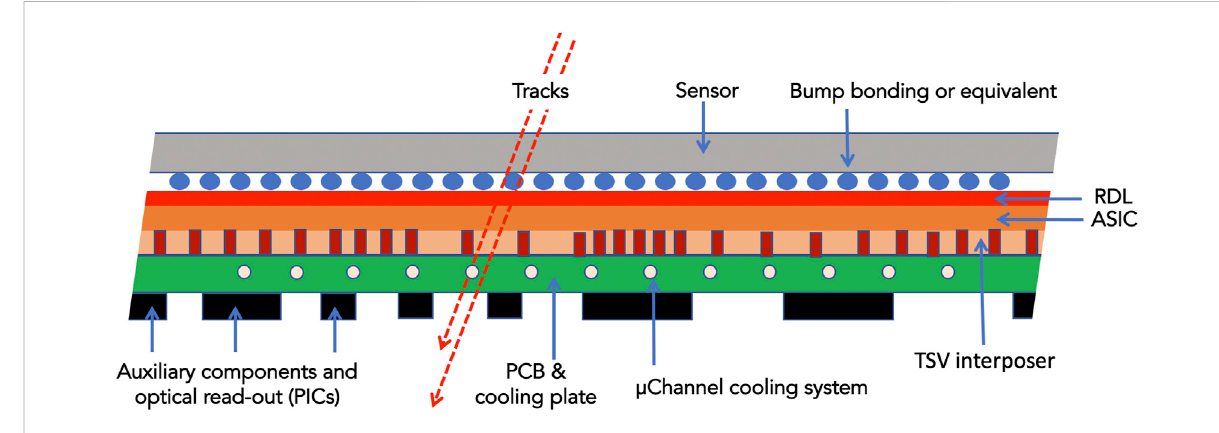
FIGURE 1 Schematic view of the envisaged tracker module spotting its levels of vertical